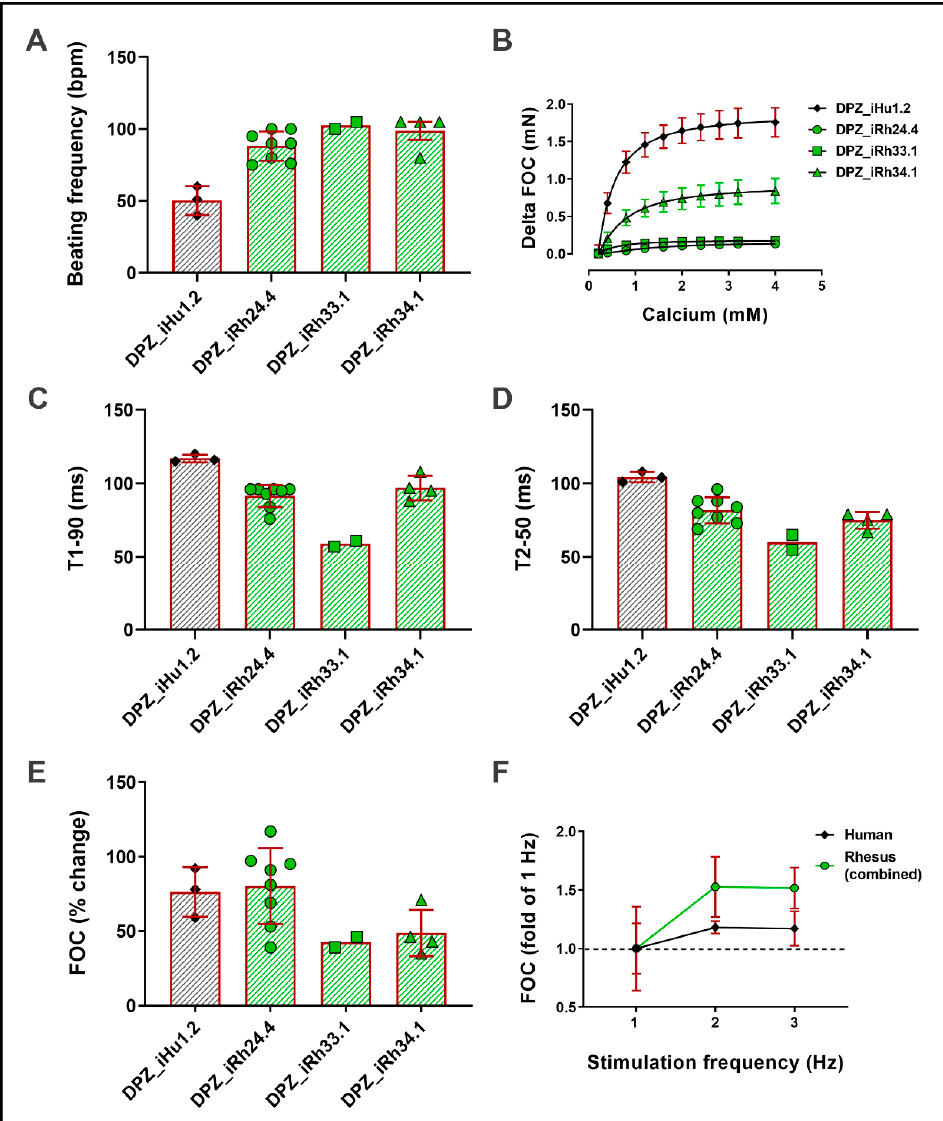
Figure 8. Functional characterization of primate engineered heart muscle (EHM). ( A ) EHM beating frequency (bpm) after four weeks of EHM culture. ( B ) Force of contraction (FOC) of EHM in response to increasing extracellular calcium concentrations. Displayed as delta of increase from 0.2 mM calcium. ( C ) The time to 90% contraction of the EHM reversely correlates with the beating frequency. ( D ) The time to 50% relaxation correlates with the 90% contraction time. ( E ) Primate EHM inotropic response